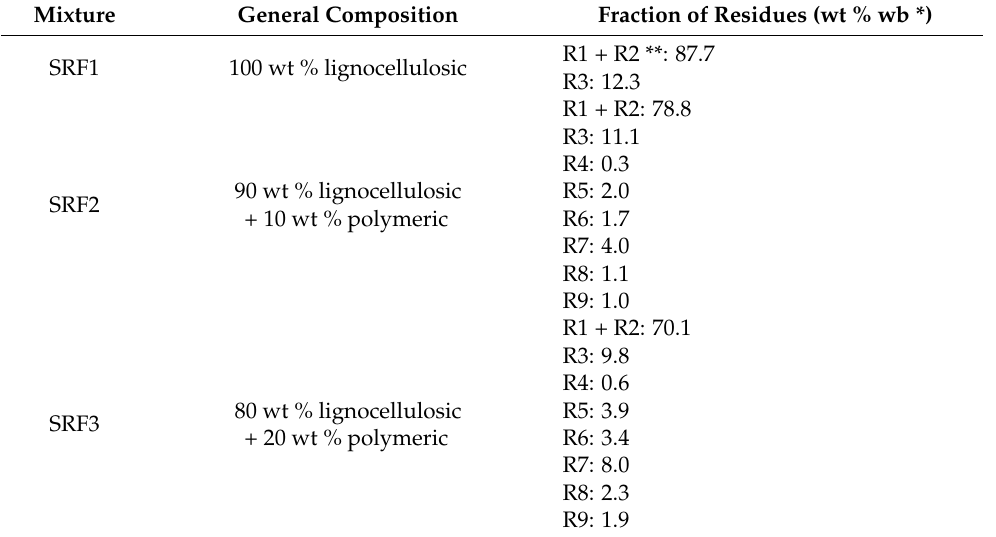
Table 2. Composition of the elaborated solid recovered fuels (SRFs) for gasification tests. Mixture